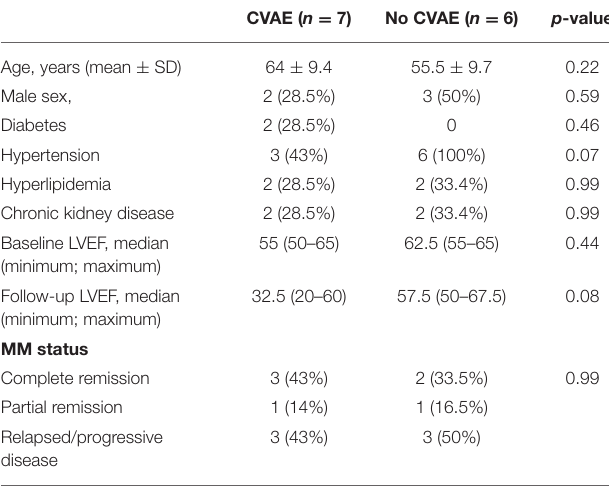
TABLE 1 | Demographic and clinical characteristics of patients treated with